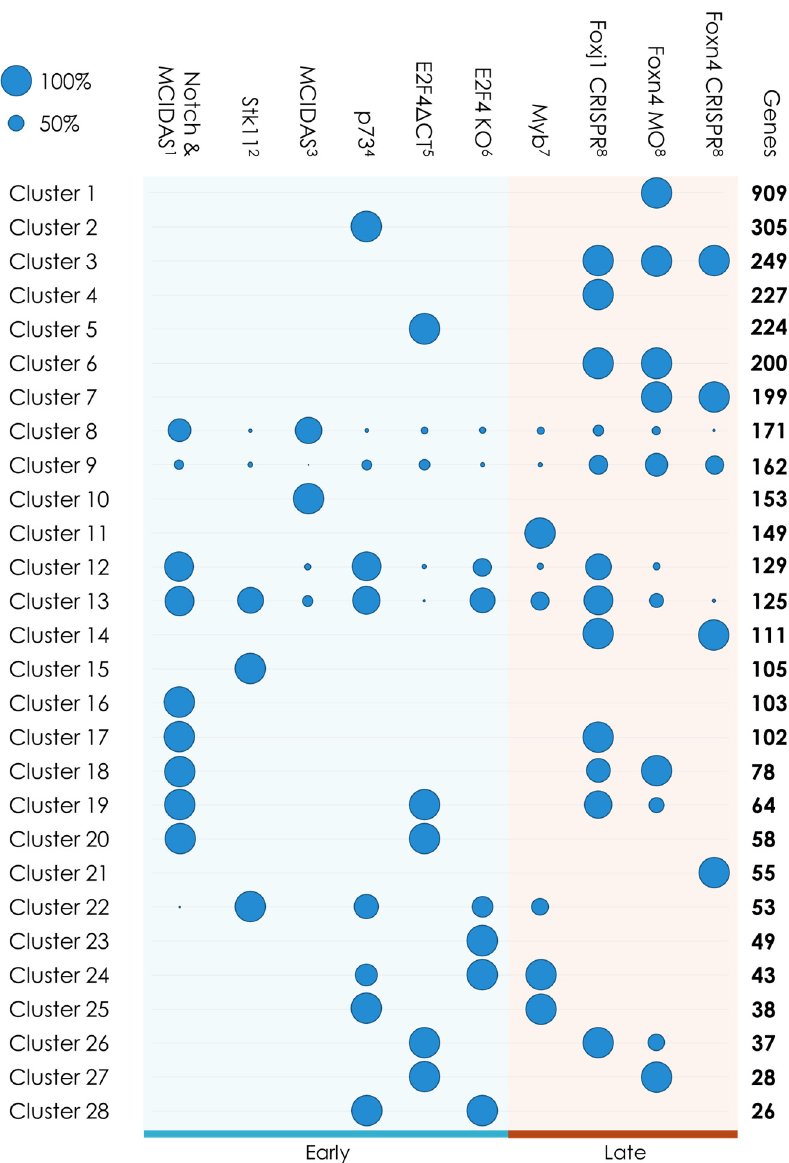
Figure 3. Schematic representation of the clustering of the results from the transcriptomics datasets. Circle size is proportional to the percentage of the cluster’s genes found in each dataset. 1 GSE76342; 2 GSE116690; 3 GSE32452; 4 GSE75715; 5 GSE59309; 6 GSE73331; 7 GSE60365; 8 GSE89271. ‘Early’ genes ( STK11 , p73 , MCIDAS and E2F4 ) are responsible for the overall regulation of multiciliation. ‘Late’ genes ( Myb , Foxn4 and Foxj1 ) activate the generation of motile cilia. Table 2. Cluster regrouping according to similarity in profiles. Pertinent GO terms were selected among the ‘biological The 18 remaining clusters can be regrouped according to the similarity of their ex- process’ GO annotation dataset and the results with the lowest p -value. pression profile and Panther [56] was used to perform Gene Ontology (GO) [57] term enrichments on each group of clusters to identify associated biological processes (Table Clusters Characteristics Genes